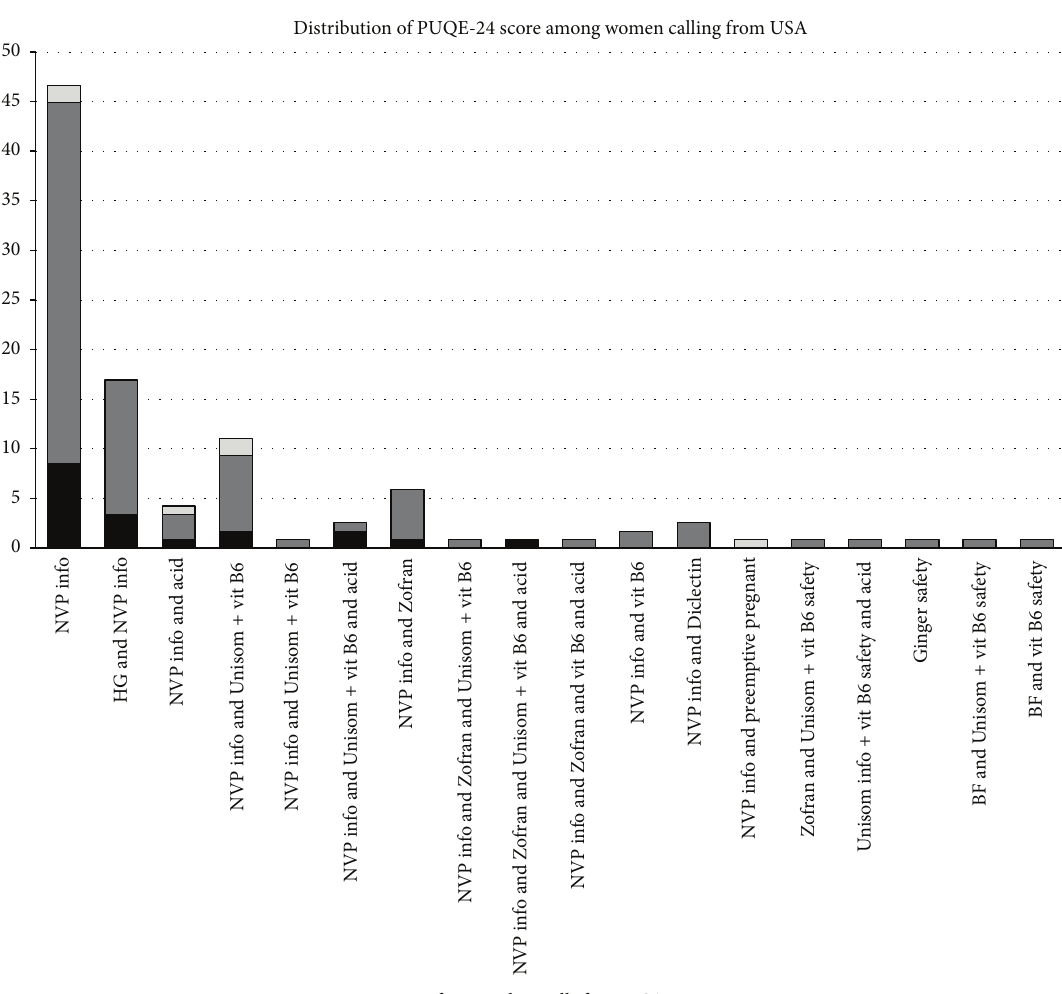
Figure 1: Distribution of PUQE-24 score among women calling from